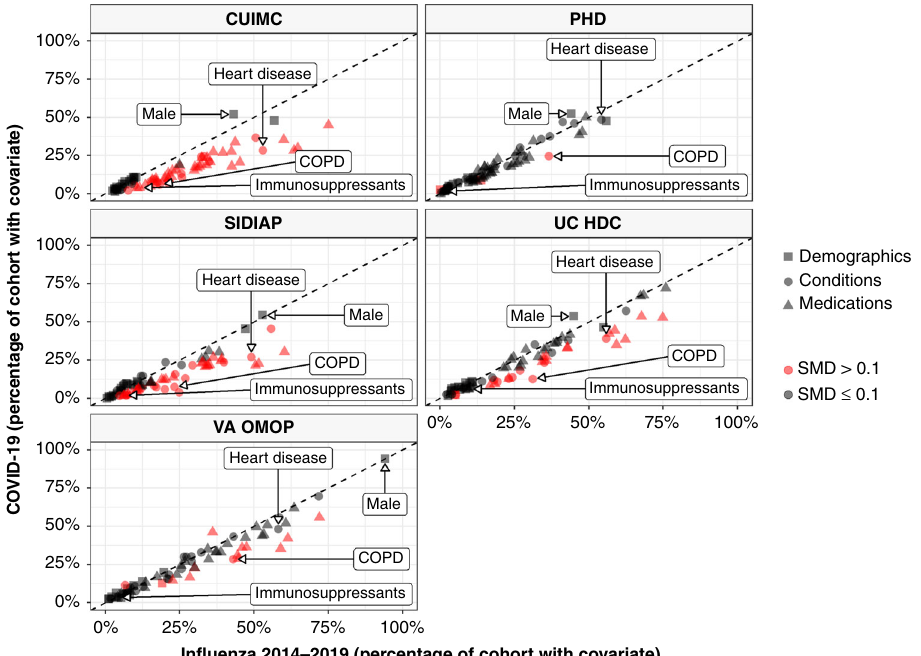
Fig. 4 Characteristics of COVID-19 patients compared to 2014 – 2019 In fl uenza patients. The plot compares demographics (age and sex), conditions (recorded over the year prior and up to the day of hospitalisation), and medications (1) from a year prior up to the day of hospitalisation, (2) from 30 days prior up to the day of hospitalisation and (3) on day of hospitalisation). Each dot represents one of these covariates with the colour indicating the absolute value of the standardised mean difference (SMD), with a SMD above 0.1 taken to indicate a difference in the prevalence of a particular covariate. The proportion male, with heart disease, with chronic obstructive pulmonary disease (COPD), and taking immunosuppressants (over the 30 days prior up